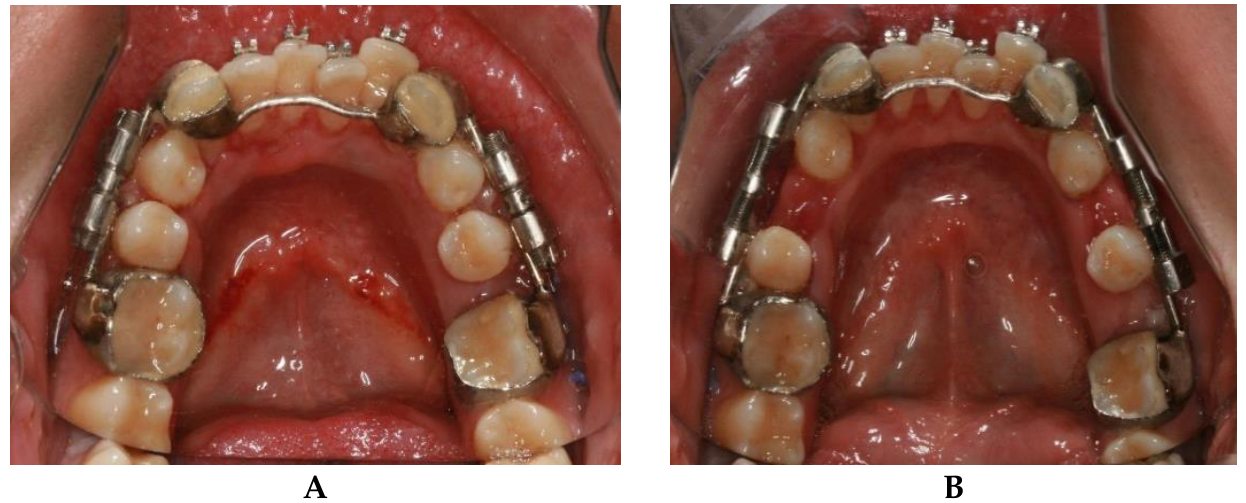
Figure 4. Intra oral mandibular photography before ( A ) and after the distraction osteogenesis ( B ) with dento-anchored